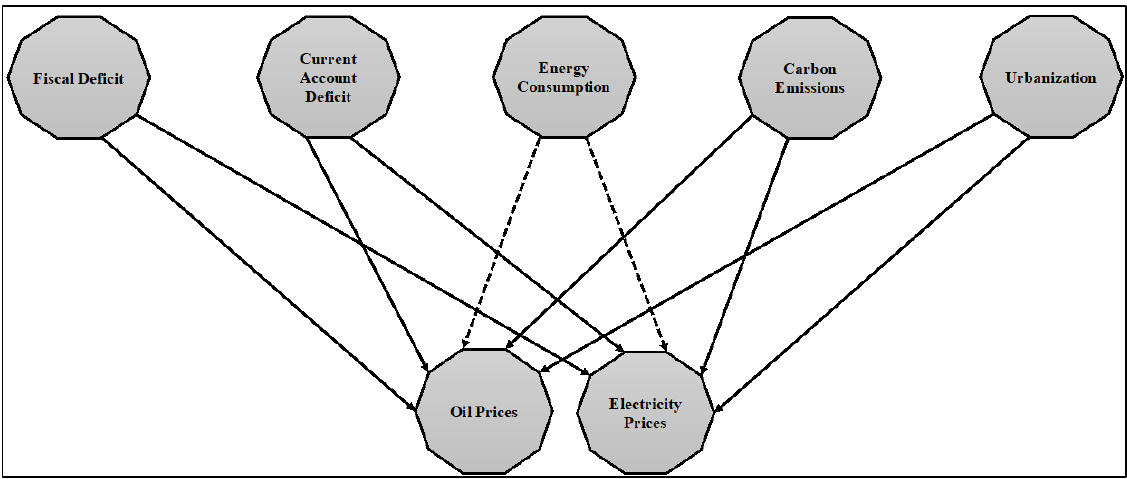
Figure 5. Graphical representation of long-run results of Model 1 and Model 2. Note: Dotted and Continuous lines represent negative and positive impact of the variables, respectively. Source: Authors’ compilation.